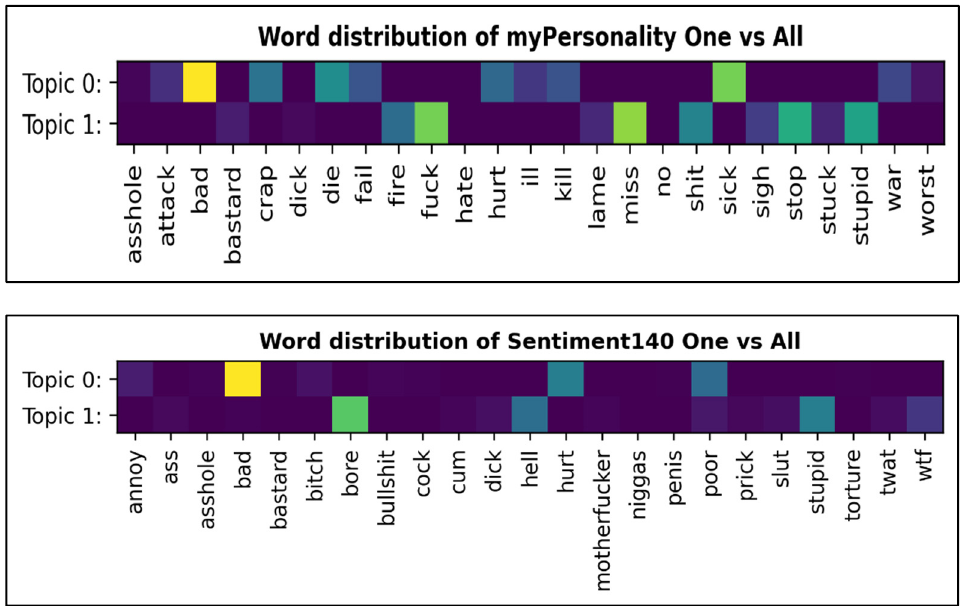
Figure 4. Word distribution of one vs. all distribution for myPersonality and Sentiment140.